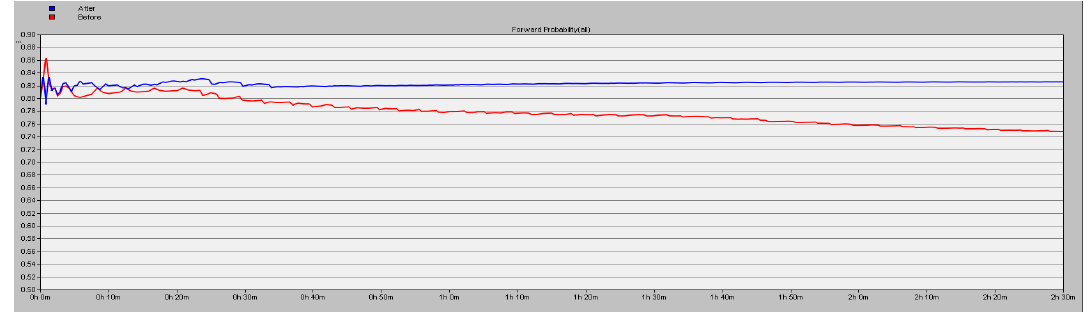
Figure 9. Forward probability of the network with one malicious node. Sensors 2016 , 16 , 1537